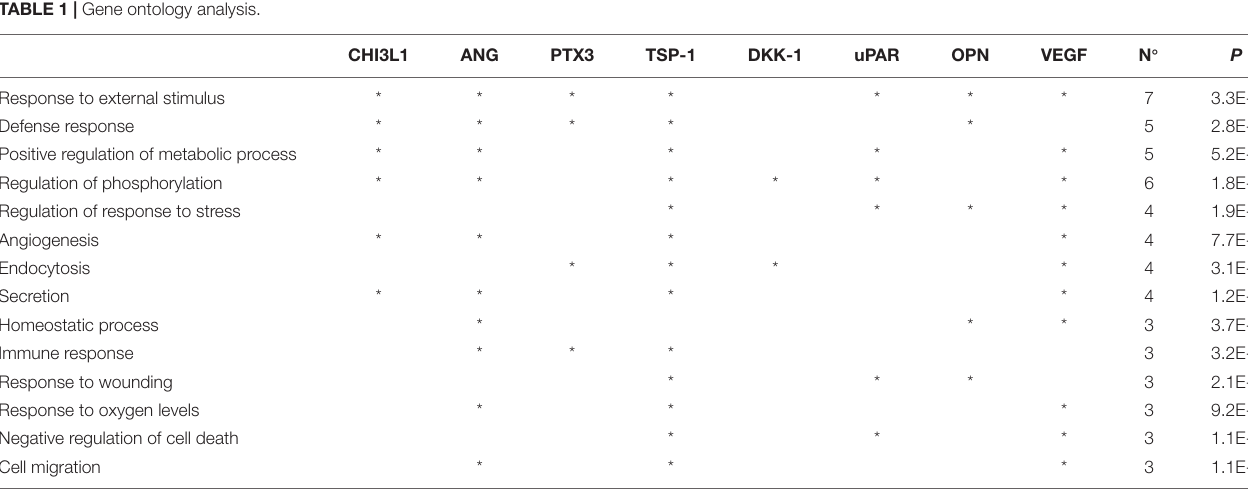
TABLE 1 | Gene ontology